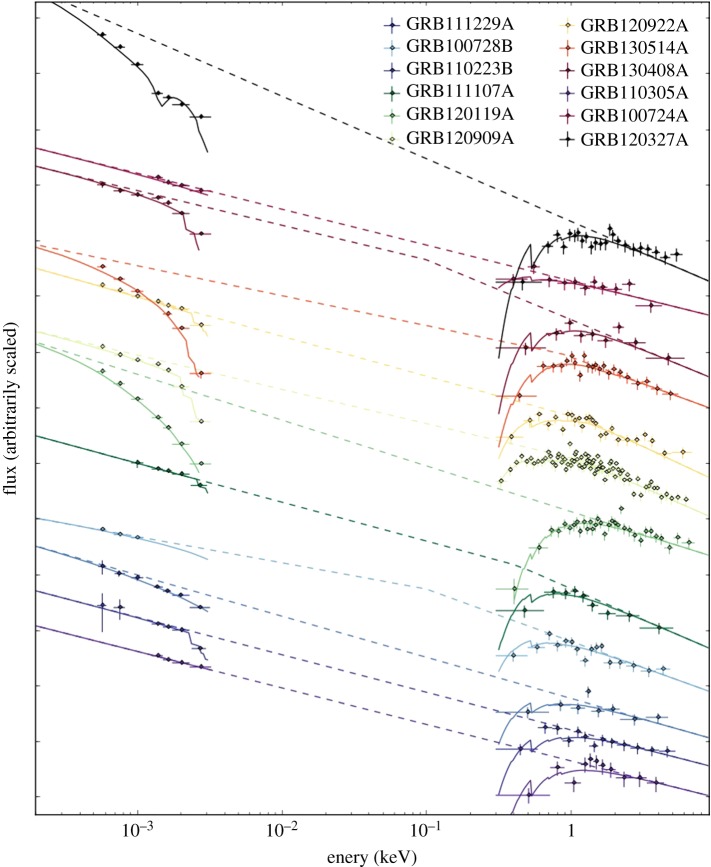
Observed GRB Swift and GROND afterglow SEDs (data points and solid lines). The best-fit intrinsic power law or broken power law spectral fits (dashed line) are also shown. Such an example GROND/Swift SED is routinely measured for approximately 40 GRBs per year [266].